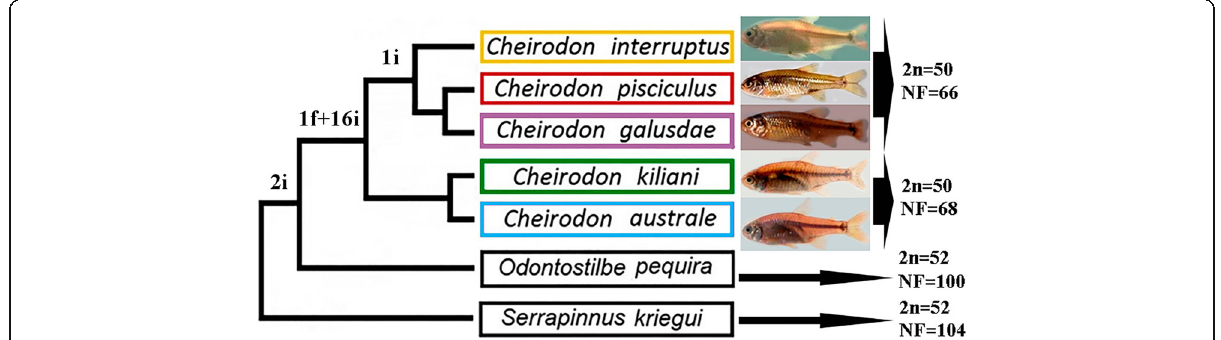
Fig. 5 Chromosomal phylogenetic hypothesis for five species of Cheirodon in Chile, with two species of genera Odontostilbe and Serrapinus serving as outgroups. The number of pericentric inversions (i) and Robertsonian fusions (f) implied in the clade divergence are included in the